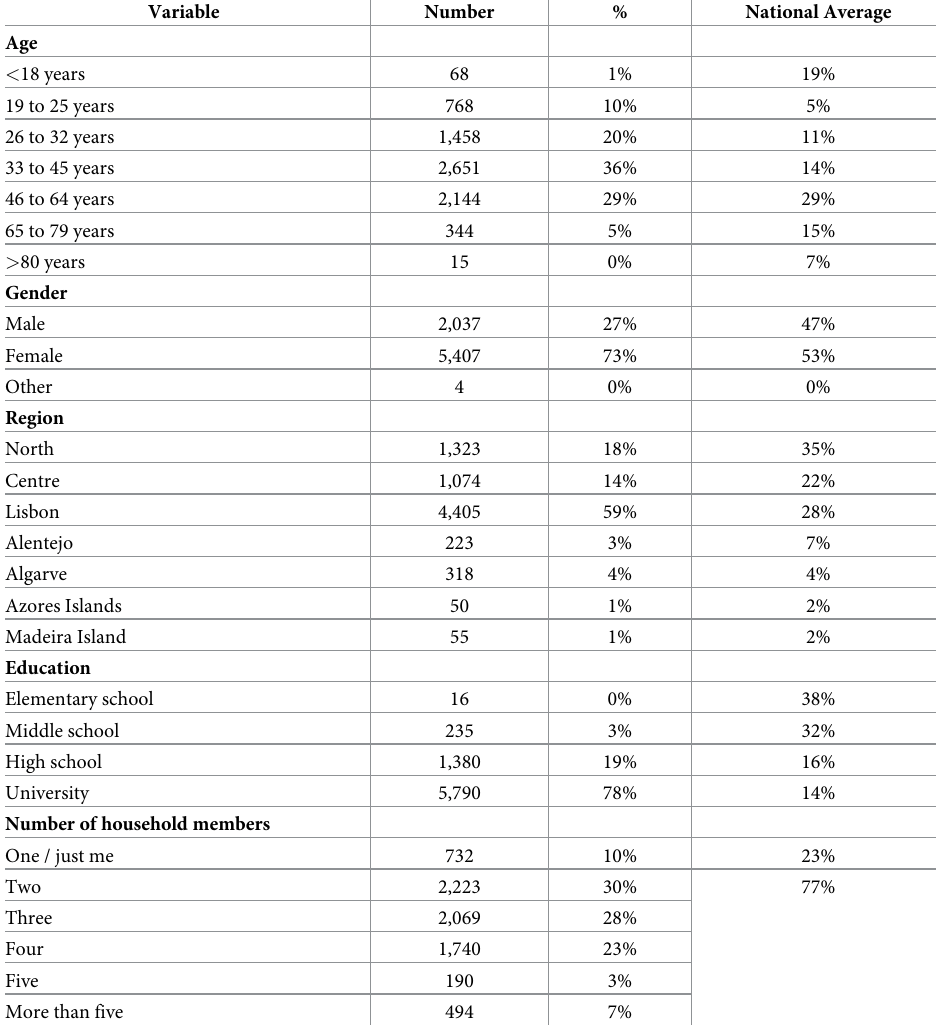
Table 2. Sample characteristics and national